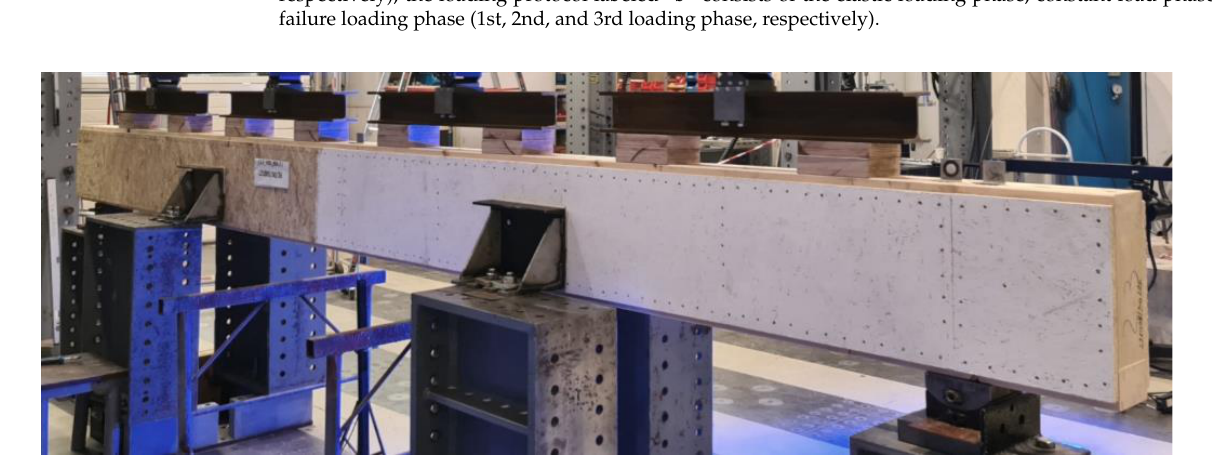
Figure 2. Composite timber beam made of waste OSB boards, fixed to a glued laminated timber frame (flanges and stiffeners) by nails.